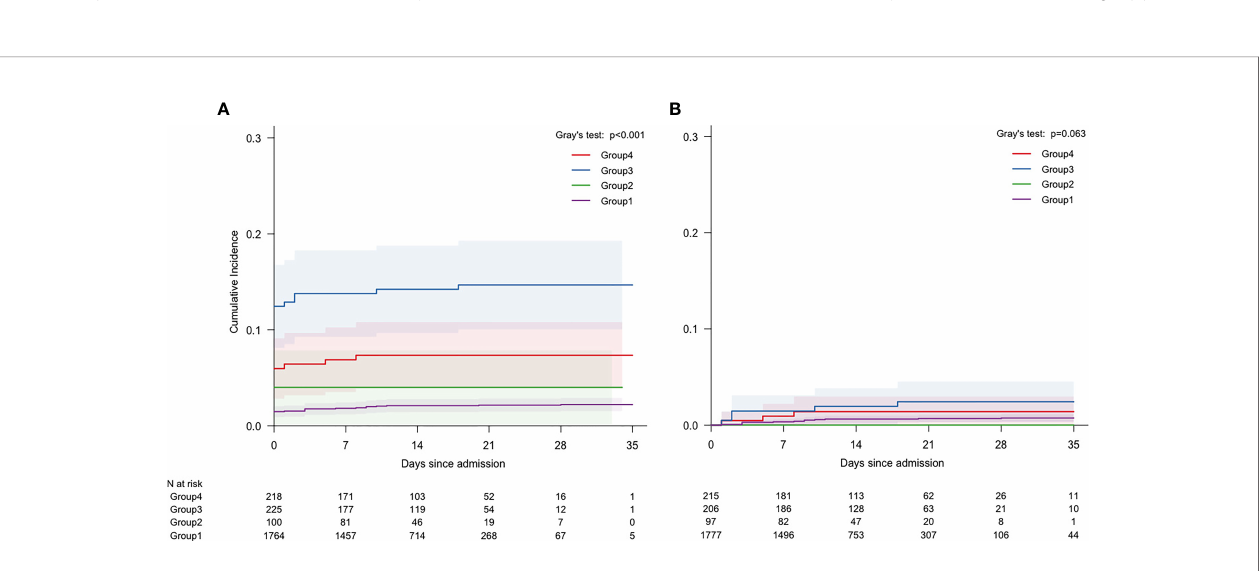
FIGURE 2 | Cumulative incidence of ICU admission strati fi ed by patients with FBG levels and diabetes: (A) All COVID-19 patients; (B) Remaining COVID-19 Patients after excluding those admitted to ICU on admission. (Unit of FBG is